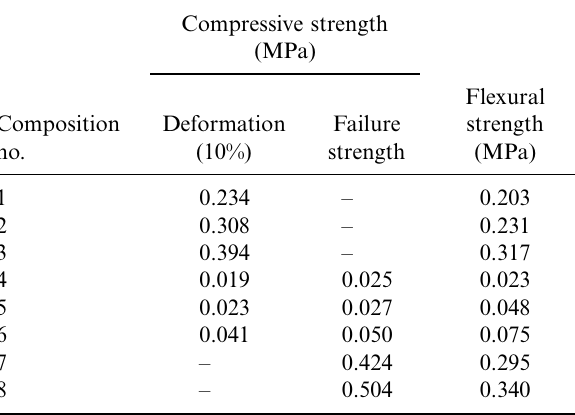
Table 4. Compressive and flexural strength of